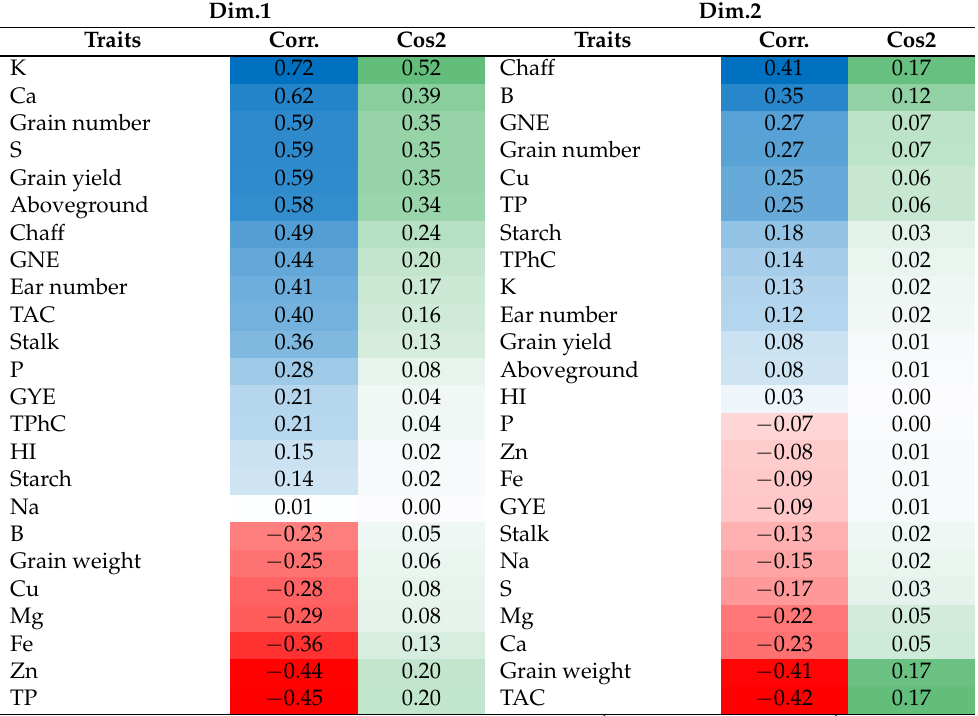
Table 4. Correlations between original variables (the wheat production, grain yield, non-mineral, and mineral nutrient traits) and the canonical axis. Dim.1 Dim.2 Traits Corr. Cos2 Traits Corr. Cos2 K 0.72 0.52 Chaff 0.41